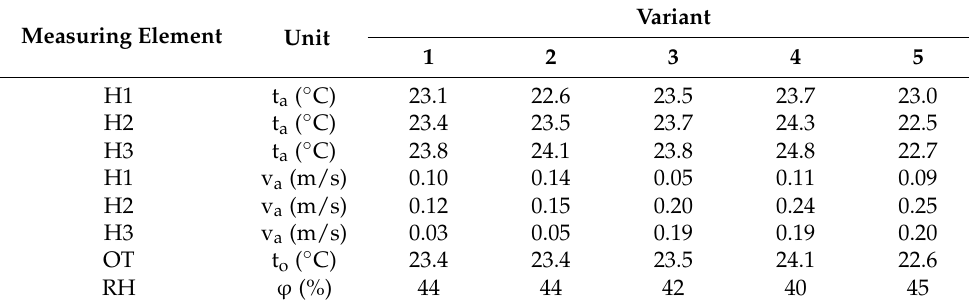
Table 4. Parameters of thermal-humidity microclimate for individual variants. Measuring